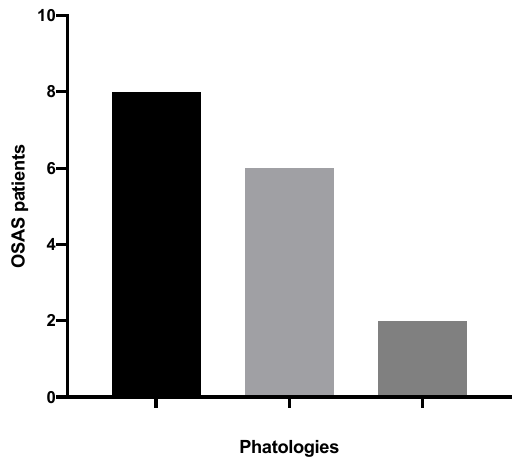
Figure 2. Demographic data.